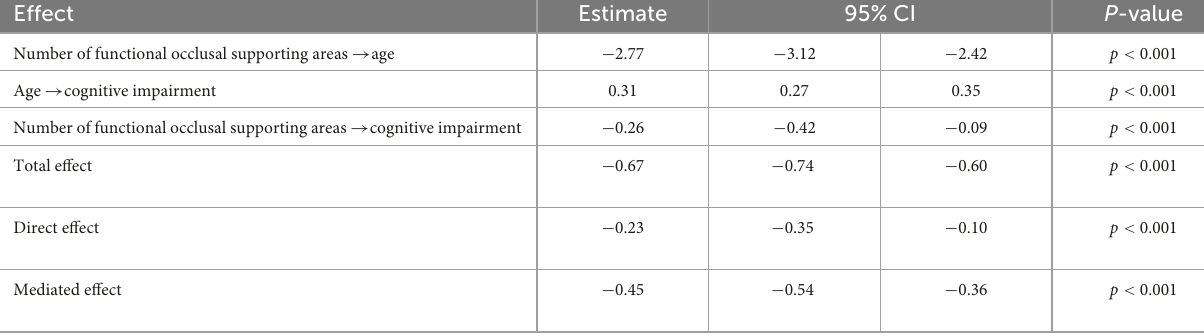
TABLE 2 Mediation analysis of age for the association between number of functional occlusal supporting areas and cognitive impairment.